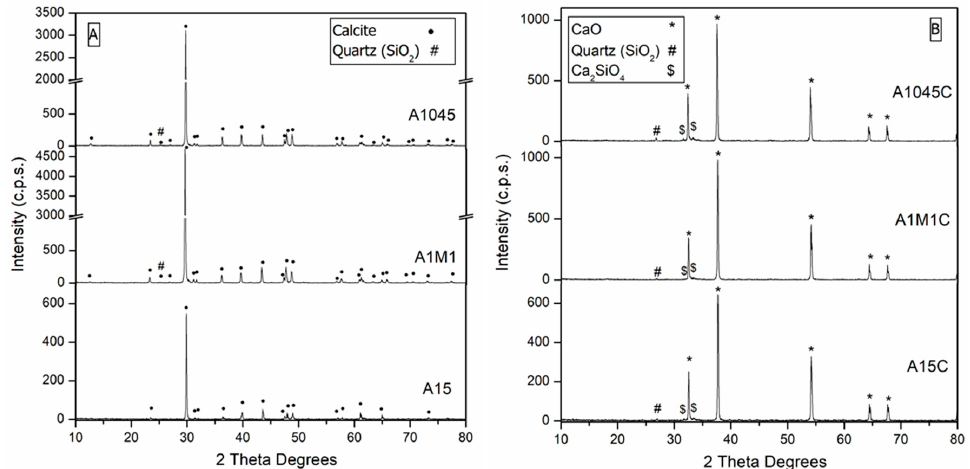
Figure 1. X-ray di ff raction (XRD) patterns. ( A ) calcites: A1045, A1M1, and A15; ( B ) calcites calcined: A1045C, A1M1C, and A15C.